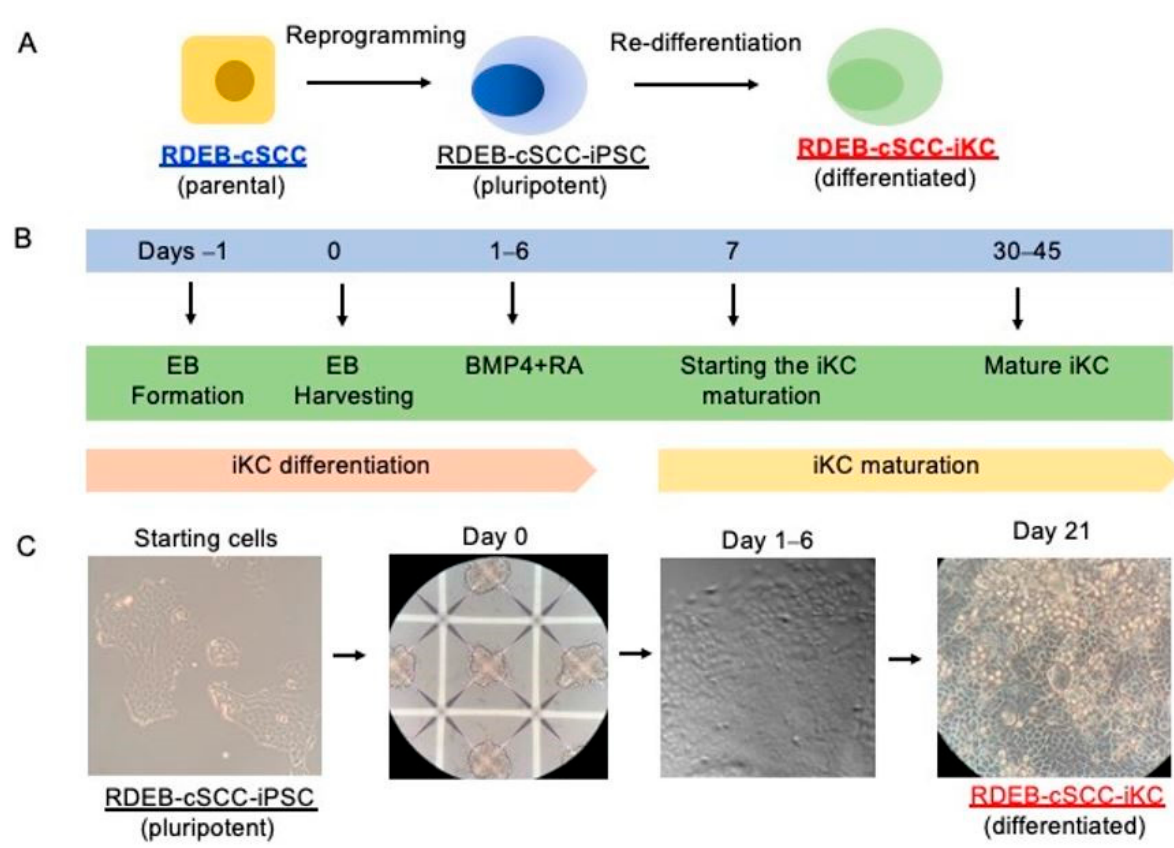
Figure 2. Re-differentiation of RDEB-cSCC into RDEB-cSCC-iKCs. ( A ) General schematic for reprogramming and re- differentiation methods. ( B ) Timeline for method to differentiate RDEB-cSCC-iPSC into RDEB-cSCC-iKC. ( C ) Representative pictures of the differentiation of RDEB-cSCC-iPSC into